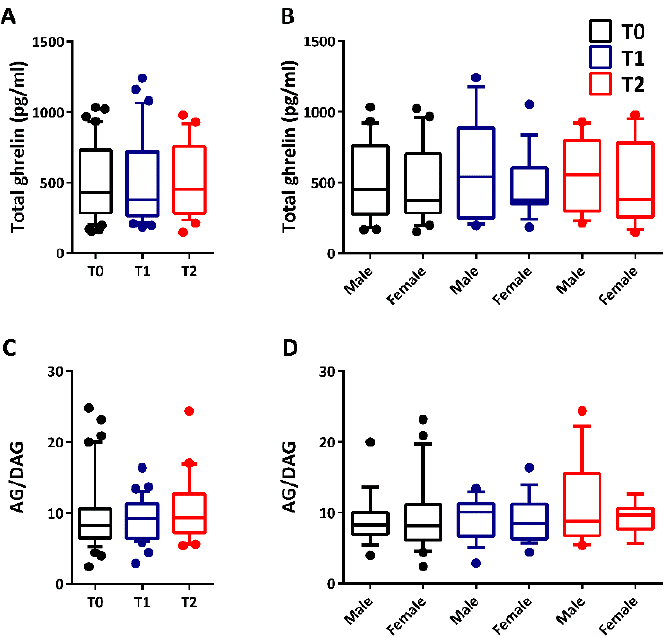
Figure 2. Total ghrelin and ghrelin (AG)-to-des-acyl ghrelin (DAG) ratio in plasma before and after drug treatment in male and female pediatric patients. In ( A ), no changes were reported for total ghrelin plasma levels after 2 months (T1; male, n = 18 and female, n = 18) or 12 months (T2; male, n = 13 and female, n = 13) from the onset of therapy (T0; male, n = 21 and female, n = 22). In ( B ), no differences were determined between male and female pediatric patients at the same time